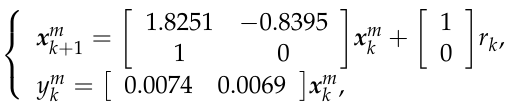
Figure 3. Data used for validating the identified closed-loop visual servo system model ( 𝜌 𝑘 -red, 𝑦 𝑘 - black).